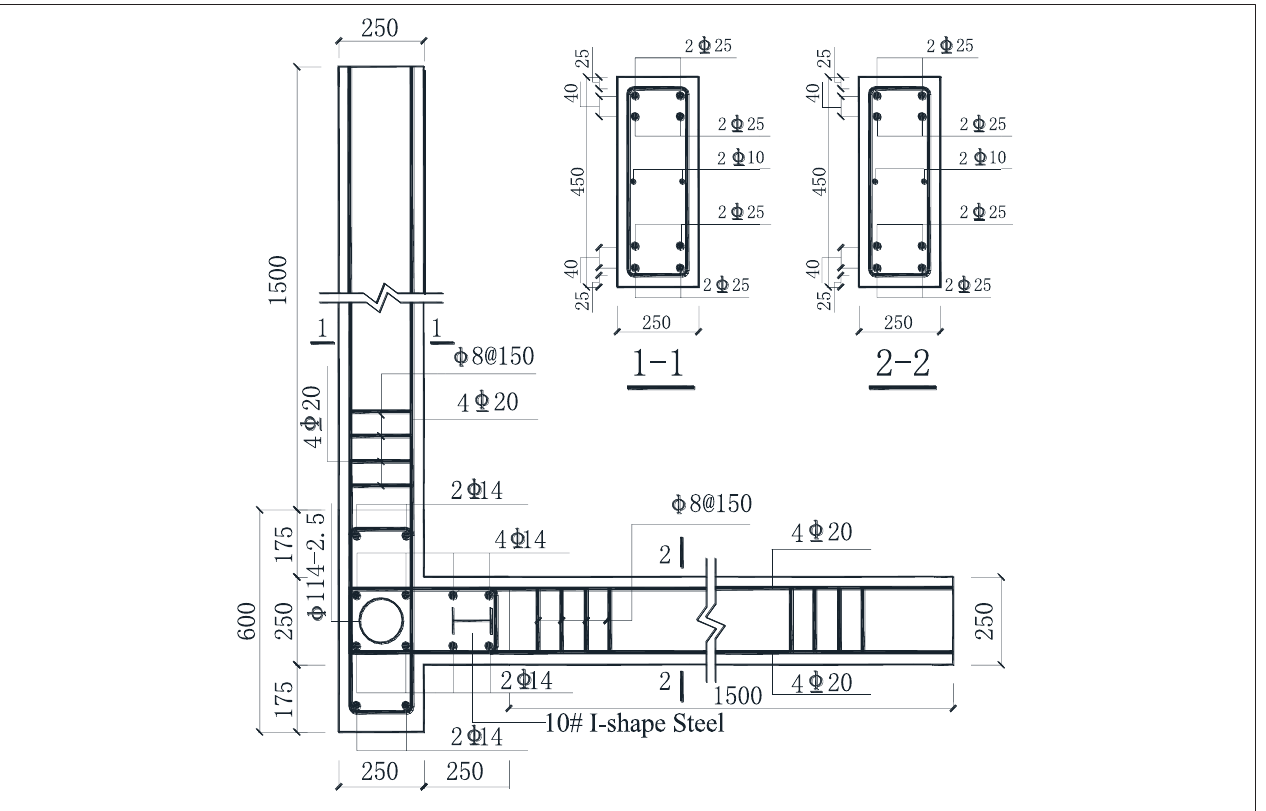
FIGURE 9 | Section of specimen JD-1 – JD-3 (Xiang et al., 2017; Xiang et al., 2019).